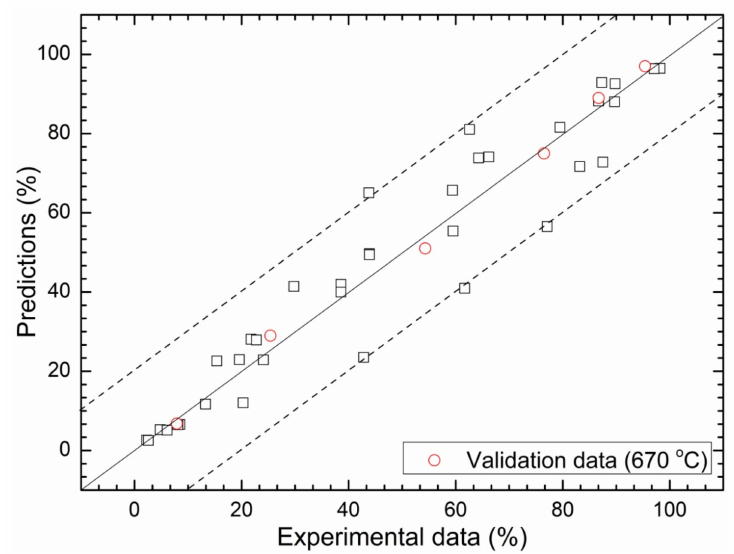
Figure 8. Comparison of predicted and experimental